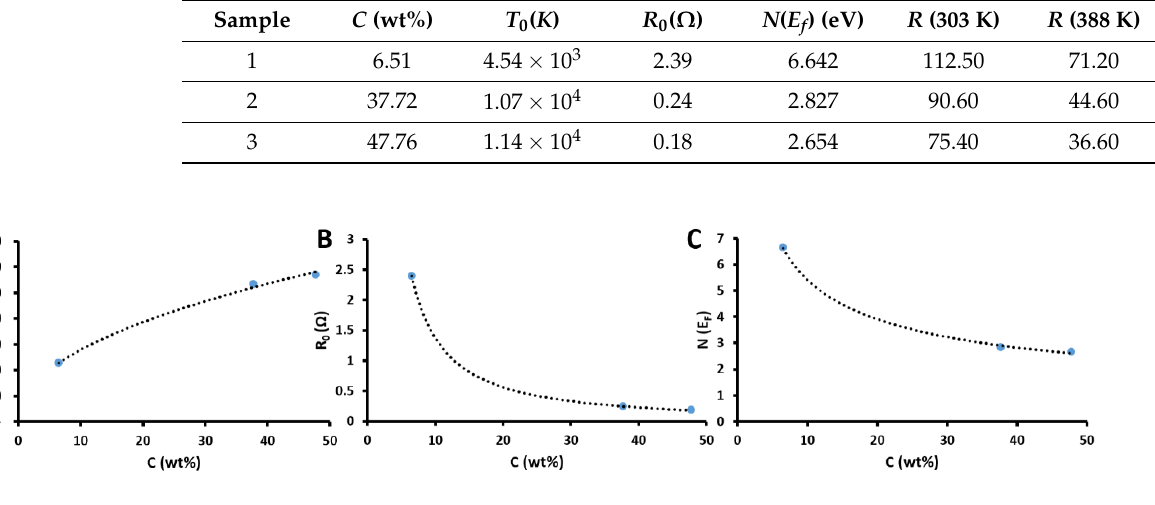
Figure 5. ( A ) Characteristic temperatures; ( B ) Resistance prefactors; ( C ) Density of localized state obtained from fits to measured ohmic resistance as a function of temperature for three nanocomposite samples with concentrations of MWCNTs of 6.51 wt%, 37.32 wt% and 47.76 wt%.